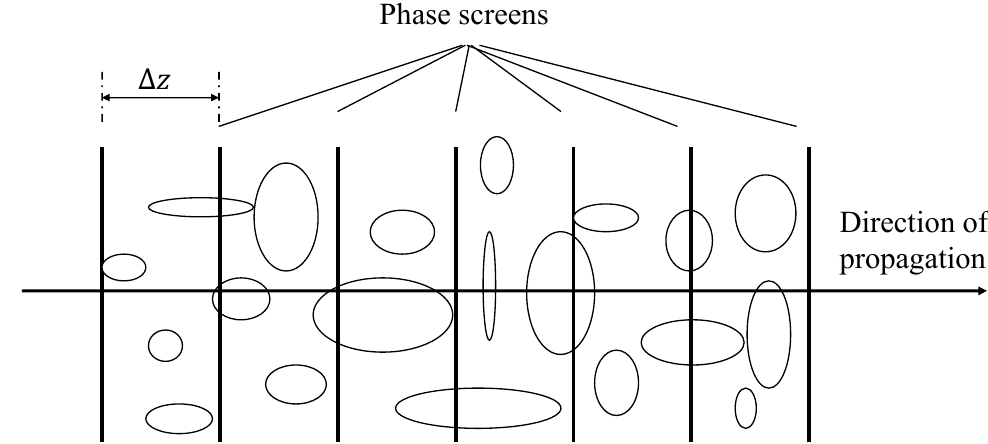
Figure 4. Phase screen model of light transmission in atmospheric turbulence.